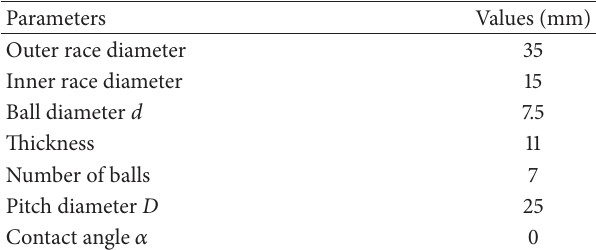
Table 1: Bearing